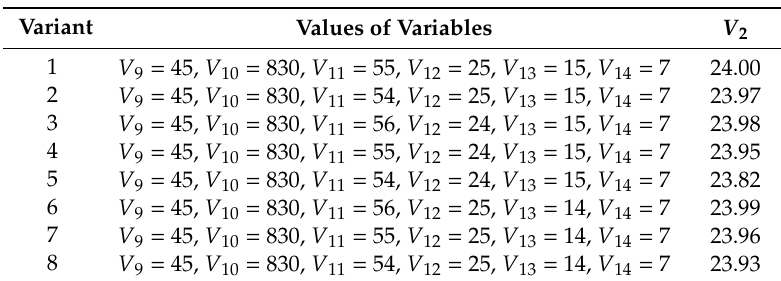
Table 2. A set of possible solutions.